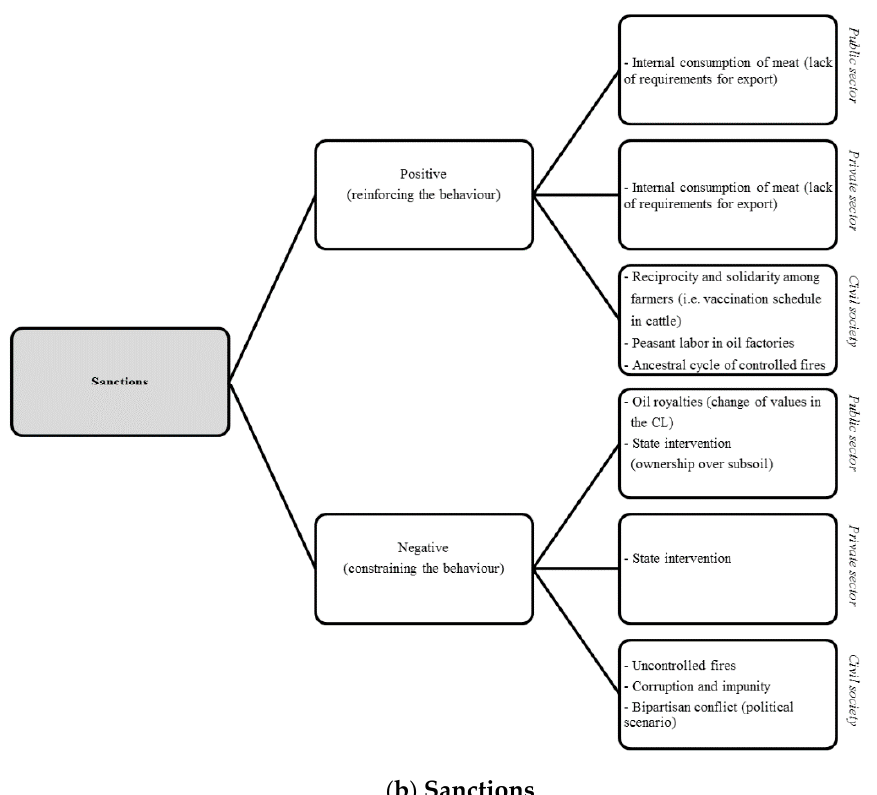
Figure 2. The perceived social norms of local groups in relation to ( a ) actions and ( b ) sanctions. Table 2. The perceived social norms